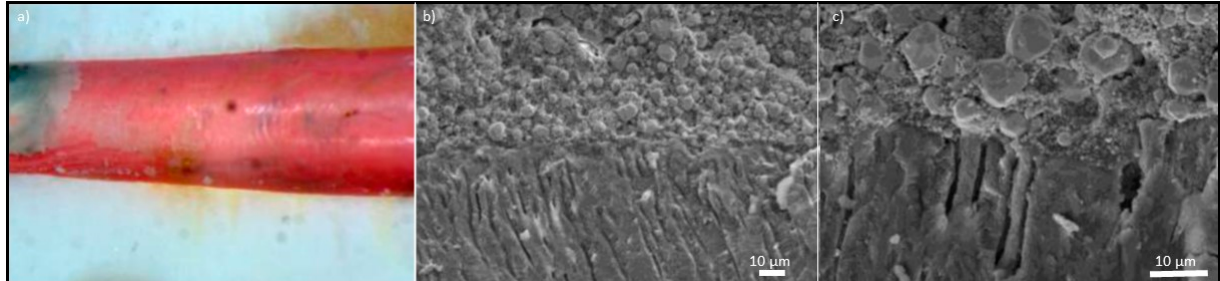
Figure 11. The borderline of the root canal wall, a thin intermediate layer of sealant and material based on a gutta-percha matrix of thermoplastic condensation with THC: ( a ) longitudinal breakthrough, viewed with LSM; ( b , c ) a visible cross- section of the dentinal tubules along their transverse to the axis of the root canal with the filling material covered with an intermediate layer of sealant, viewed with SEM.